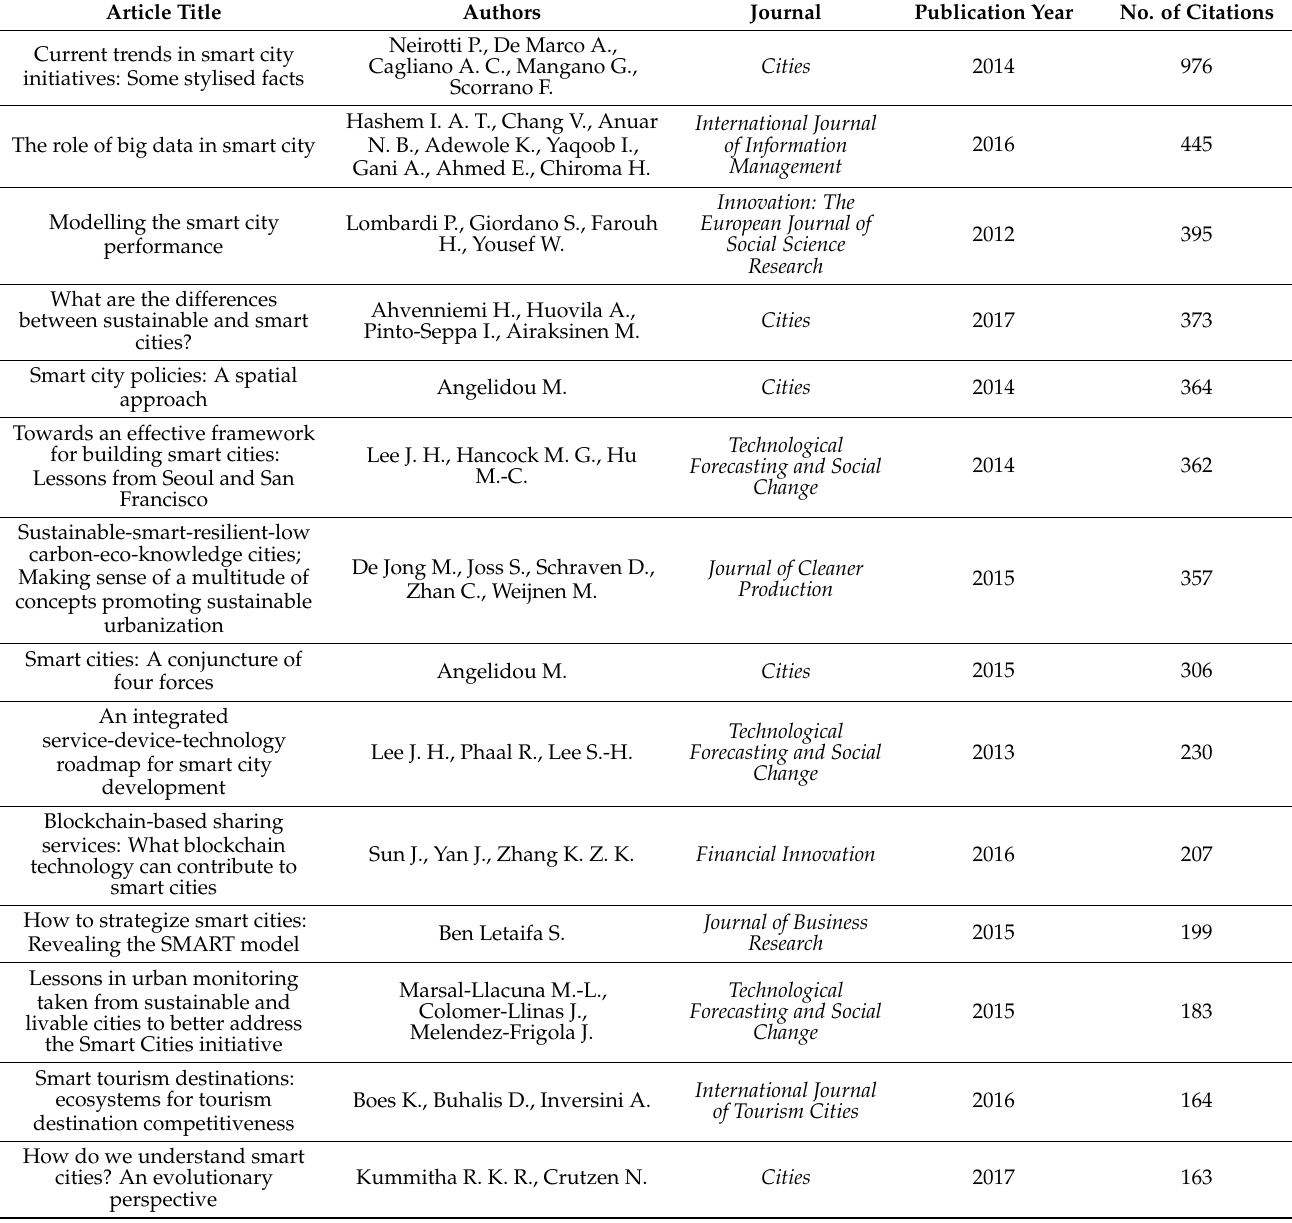
Table 1. Articles with the highest number of